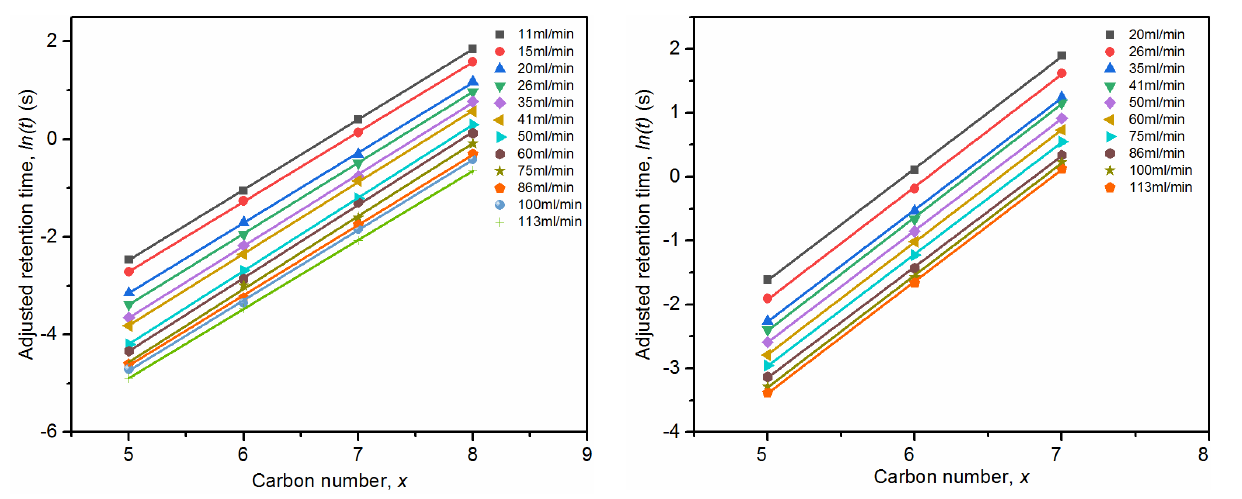
Figure 6: Adjustment retention time of probe molecules for sample N375